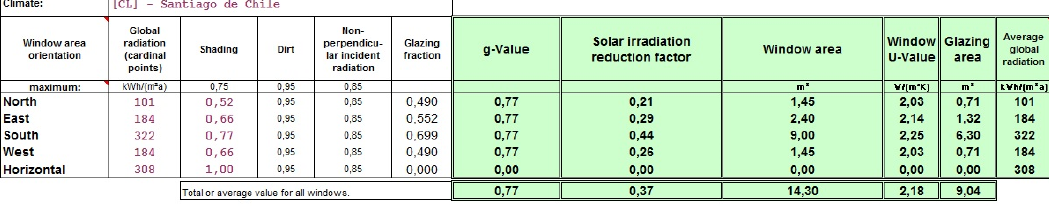
Figure A5. Windows. Figure A5. Windows.